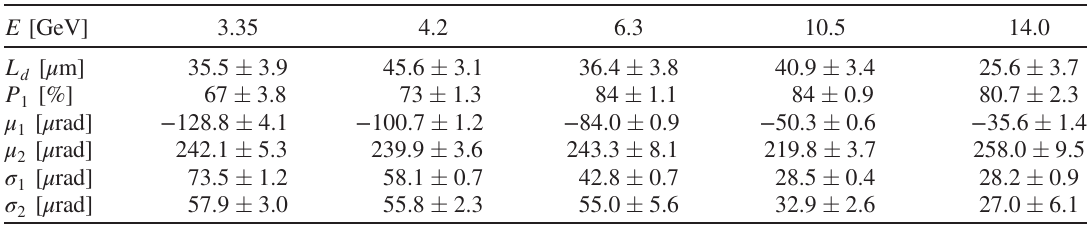
TABLE VI. A table of the fitting parameters for the crystal in “ volume capture ” orientation using the described